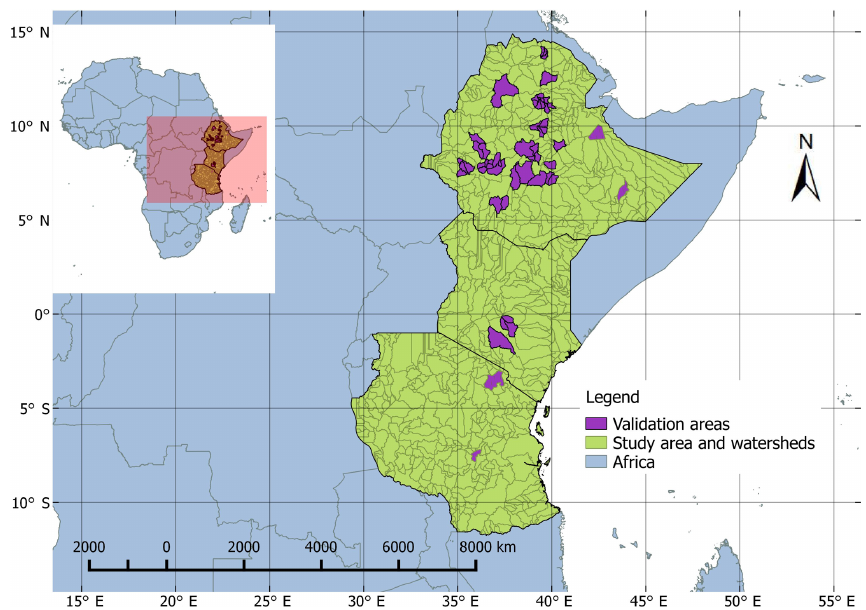
Figure 1. Map of Africa and study regions (Ethiopia, Kenya, and Tanzania) with data validation areas (EthioShed1–17, KenShed1 and 2, and TanzShed1&2). The basins are retrieved from the WaterBase global data portal (http://www.waterbase.org/, last access: 18 January